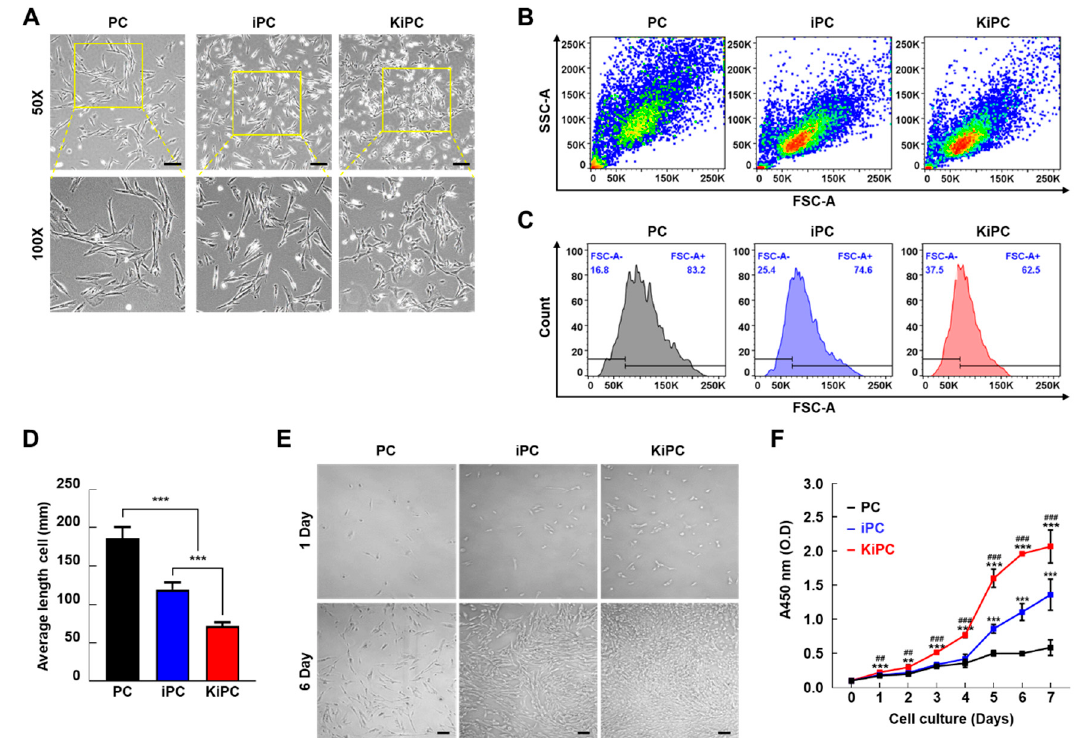
Figure 2. Differences in cellular morphology, size, and proliferation among PCs, iPCs, and KiPCs. ( A ) Representative bright-field images of PCs, iPCs, and KiPCs. Scale bar = 100 µm. Magnification 100× and 200×. ( B ) Flow cytometry analysis of cell populations by forward scatter area (FSC-A) and side scatter area (SSC-A) in PCs, iPCs, and KiPCs. ( C ) Quantitative analysis of FSC-A (cell size) in PCs, iPCs, and KiPCs. Scale is an arbitrary representation of cell size across the entire population. Blue numbers in each figure represent the cell populations in the gated area. ( D ) Lengths of 20 cells in different areas. ( E ) Representative bright-field images of PCs, iPCs, and KiPCs after 1 or 6 days of culture. Scale bar = 100 µm. Magnification 100×. ( F ) Proliferation was measured by CCK-8 assay. Each sample was measured four times at the indicated time points. # denotes a statistically significant difference compared with iPCs; * denotes a statistically significant difference compared with PCs. All experiments were performed using at least three replicates, and the results are representative of three independent experiments. Data are presented as means ± standard deviation. * p < 0.05, ** p < 0.01, *** p < 0.001; one-way analysis of variance with Holm–Sidak multiple comparisons. ## p < 0.01, ### p < 0.001; one-way analysis of variance with Holm–Sidak multiple